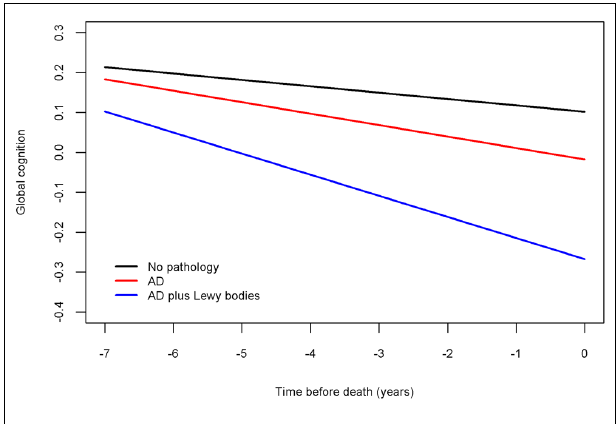
FIGURE 2 | Contributions of combinations of the neuropathologies to cognitive decline (model-derived slopes; top line shows the minimal decline associated with no pathology, the red line shows the increased rate of decline associated withAD pathology, and the blue line shows the increased rate of decline associated with LBD